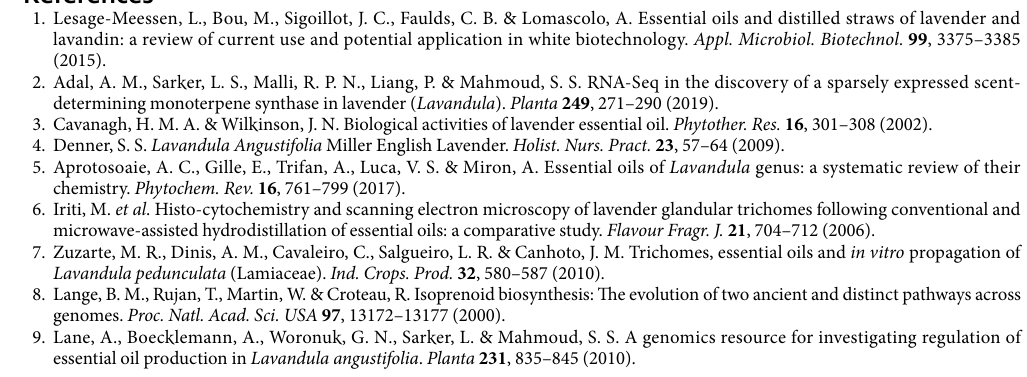
Supplementary Table S6. β -actin was used as an internal ref. 2 . The 2 − ∆∆ CT method was used to calculate the rel- ative gene expression levels 39 . For each gene, three technical and biological replicates were used in the qRT-PCR